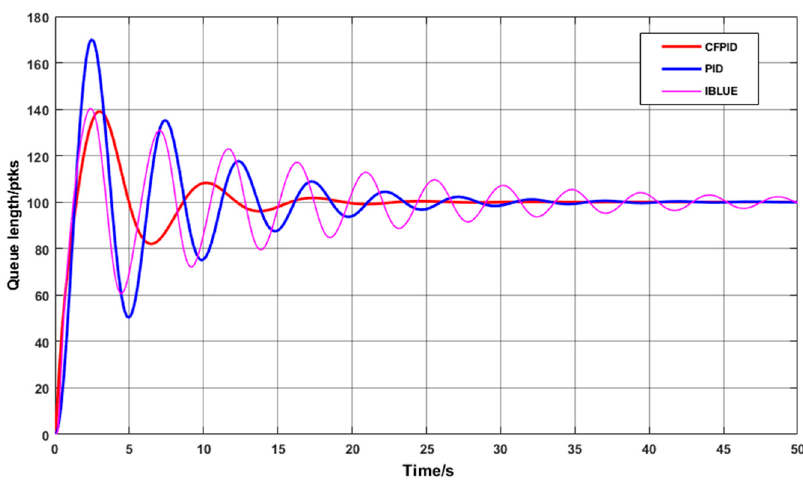
Figure 6. One-hundred instantaneous queue length curves for nodes.